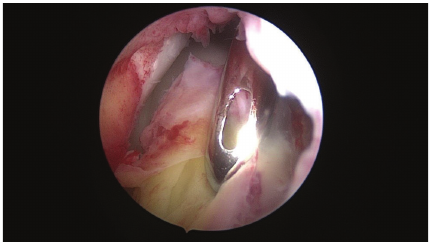
Figure 4: Bursoscopic image of the bicipital bursa: small amounts of fibrin pannus were found adherent to the bursal